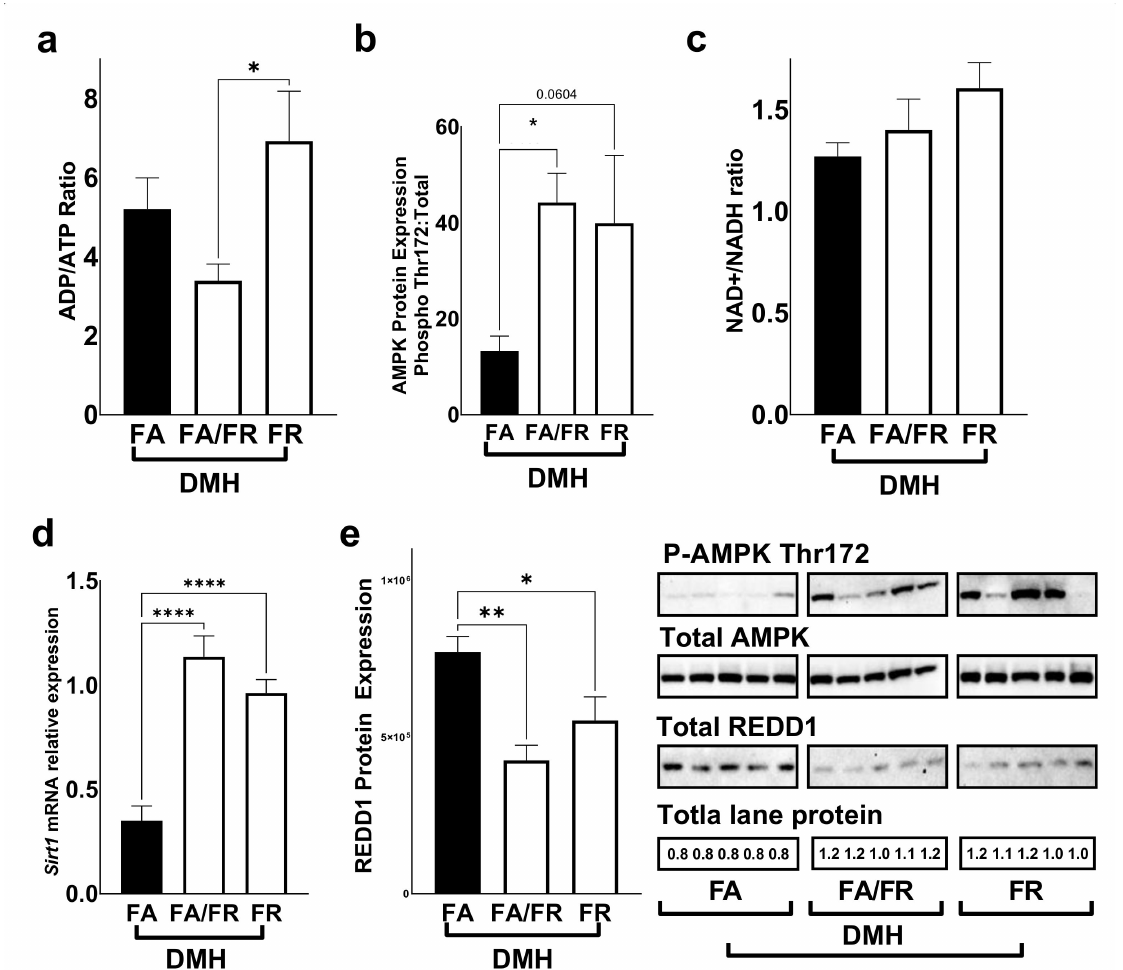
Figure 3. Folate restriction alters energy levels and regulators of mTOR in the liver of DMH-treated mice. ( a ) ADP/ATP ratio in the liver. ( b ) Western blot quantification of AMPK (Thr172) protein phosphorylation. ( c ) NAD+/NADH ratio ( d ). Sirt1 mRNA relative expression. ( e ) Western blot quantification of REDD1 protein levels. FA = folate adequate diet, FA/FR = folate adequate diet followed by initiation of folate-restricted diet one week prior to DMH, FR = folate-restricted diet. Western blots were normalized to total lane proteins. DMH = dimethylhydrazine, liver/colon carcinogenic treatment; n = 3 for energy assays; n = 5–7 for western blots and qPCR analysis; Bars, S.E.M, * p < 0.05, ** p < 0.005, **** p <